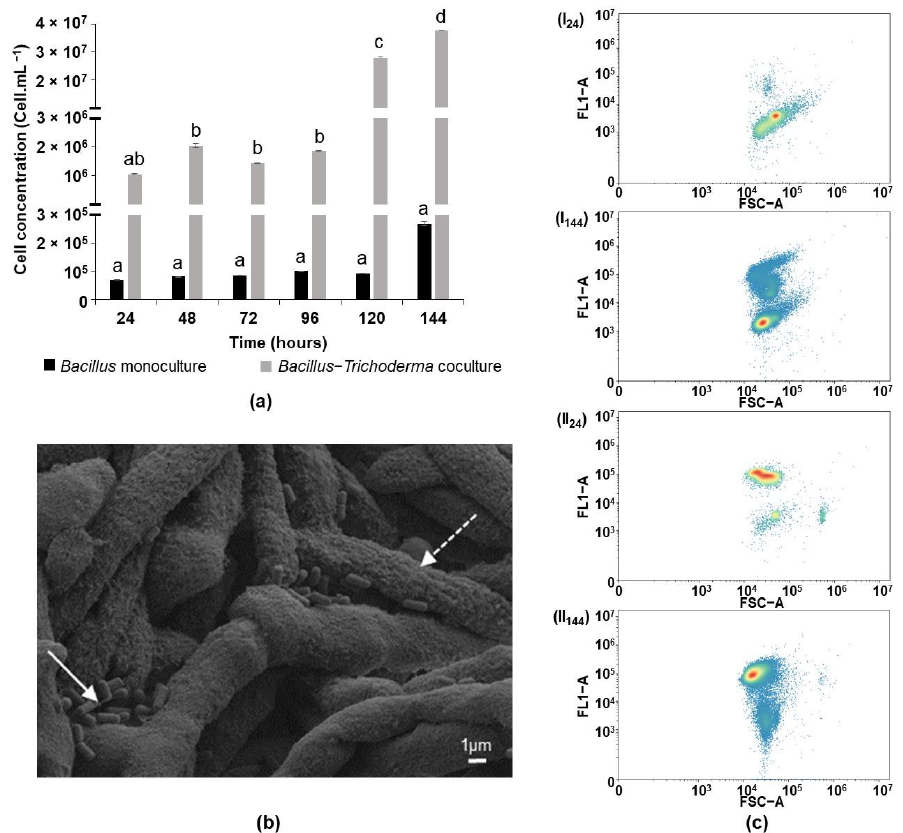
Figure 3. ( a ) Follow up by flow cytometry of the concentration of B. velezensis cells in monoculture and coculture with T. harzianum in MM for 6 days of culture, ( b ) SEM picture of B. velezensis cells (full line arrow) attached to T. harzianum ’s mycelium (dotted line arrow) in a 6 day old coculture in MM, ( c ) Cytogram (FL1 channel for green fluorescence versus side scatter in arbitrary units) of B. velezensis GA1 treated with RSG after 24 and 144 h of growth in (I) monoculture in MM and (II) coculture with T. harzianum in MM. All the results are displayed on a FL1 dot plot on the basis of the analysis of 40,000 microbial cells by flow cytometry. The graph ( a ) shows the mean and standard deviation of three biological replicates. Different letters indicate groups of statistically different conditions (one-way ANOVA and Tukey’s HSD test (honestly significantly different); α = 0.05). After 6 days, the final cell concentration of the Bacillus was approximately 2.5 × 10 5 cells mL − 1 , which corresponds to only 12.5 times more cells than were present in the initial inoculum. This concentration is not significantly different from the inoculum’s